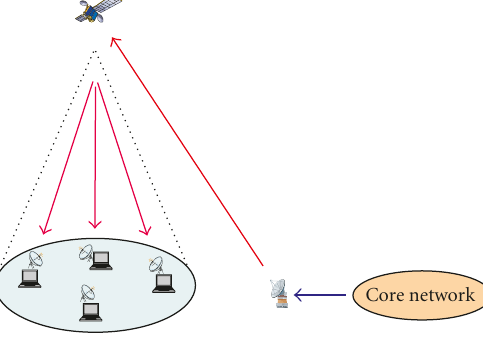
Figure 1: Cross-layer CAC-TCP flow chart.